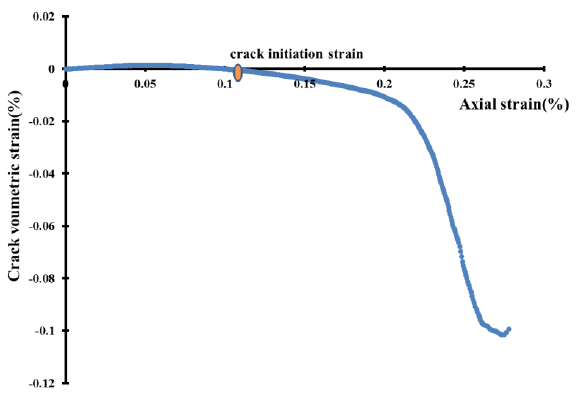
Figure 6: Crack volumetric strain method for crack initiation threshold determination for Hungarian granitic rock sample (uniaxial compression case)